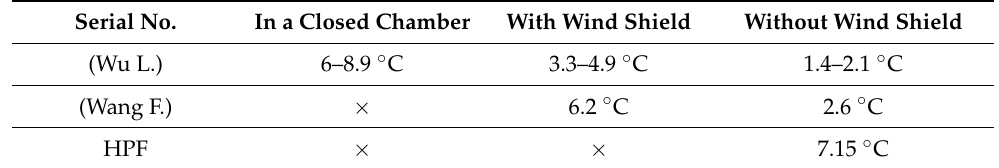
Table 2. Cooling results in different environments. Serial No.